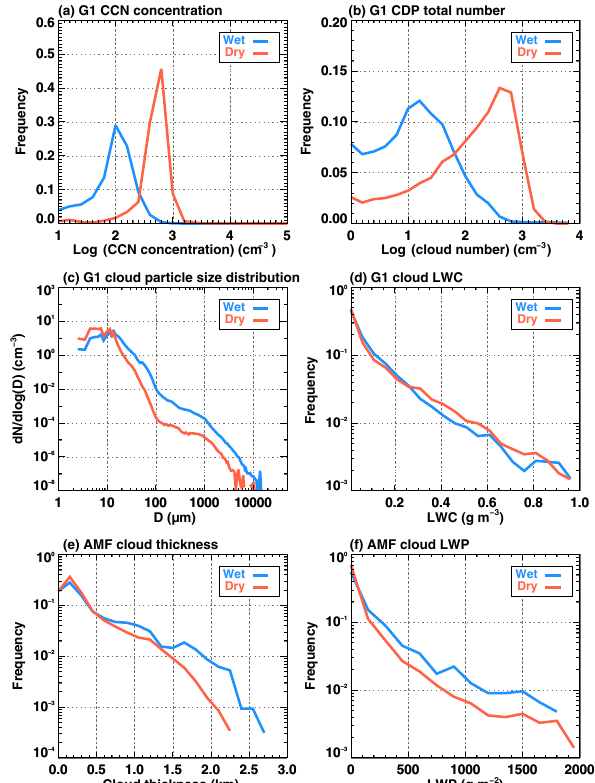
Figure 13. Shallow cumulus cloud micro- and macrophysics ob- served by AAF G1 aircraft and AMF surface instrumentation at the T3 site during the two IOPs in GoAmazon2014/5. (a) Cloud condensation nuclei number concentration, (b) cloud droplet total number concentration, (c) cloud particle size distribution, (d) cloud liquid water content (LWC), (e) cloud thickness and (f) cloud liquid water path